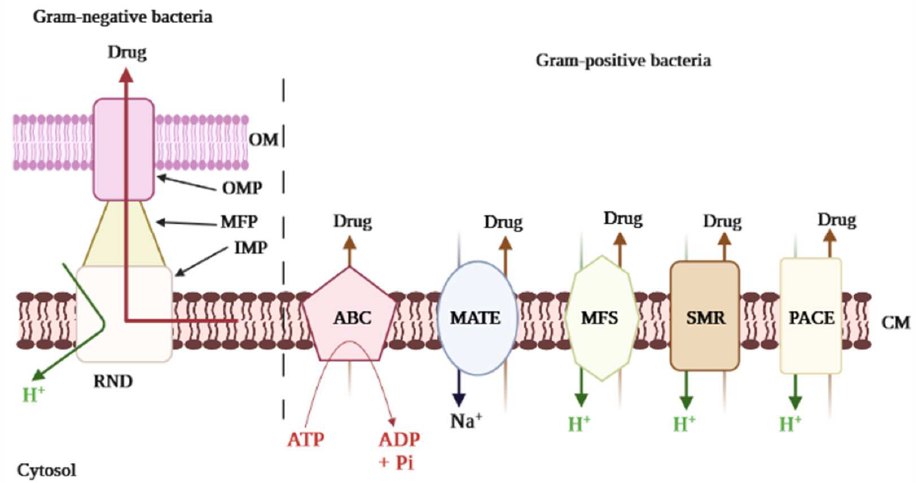
Figure 1. Major efflux pump systems in bacteria. The major efflux pump family, namely ABC (ATP Binding Cassette), MATE (Multidrug and Toxic Compound Extrusion), MFS (Major Facilitator Superfamily), SMR (Small Multidrug Resistance), RND (Resistance Nodulation and Cell Division), and PACE (Proteobacterial Antimicrobial Compound Efflux) are represented. The specificity of Gram-negative bacteria is shown with the presence of the OM (Outer Membrane) in addition to the CM (Cytoplasmic Membrane). The components of RND are OMP (Outer Membrane Protein), MFP (Membrane Fusion Protein), and IMP (Inner Membrane Protein), making the tripartite confor- mation. The primary transporters use energy derived from ATP hydrolysis (ABC), whereas the sec- ondary transporters use the energy from the H + motive force or the Na + electrochemical gradient.